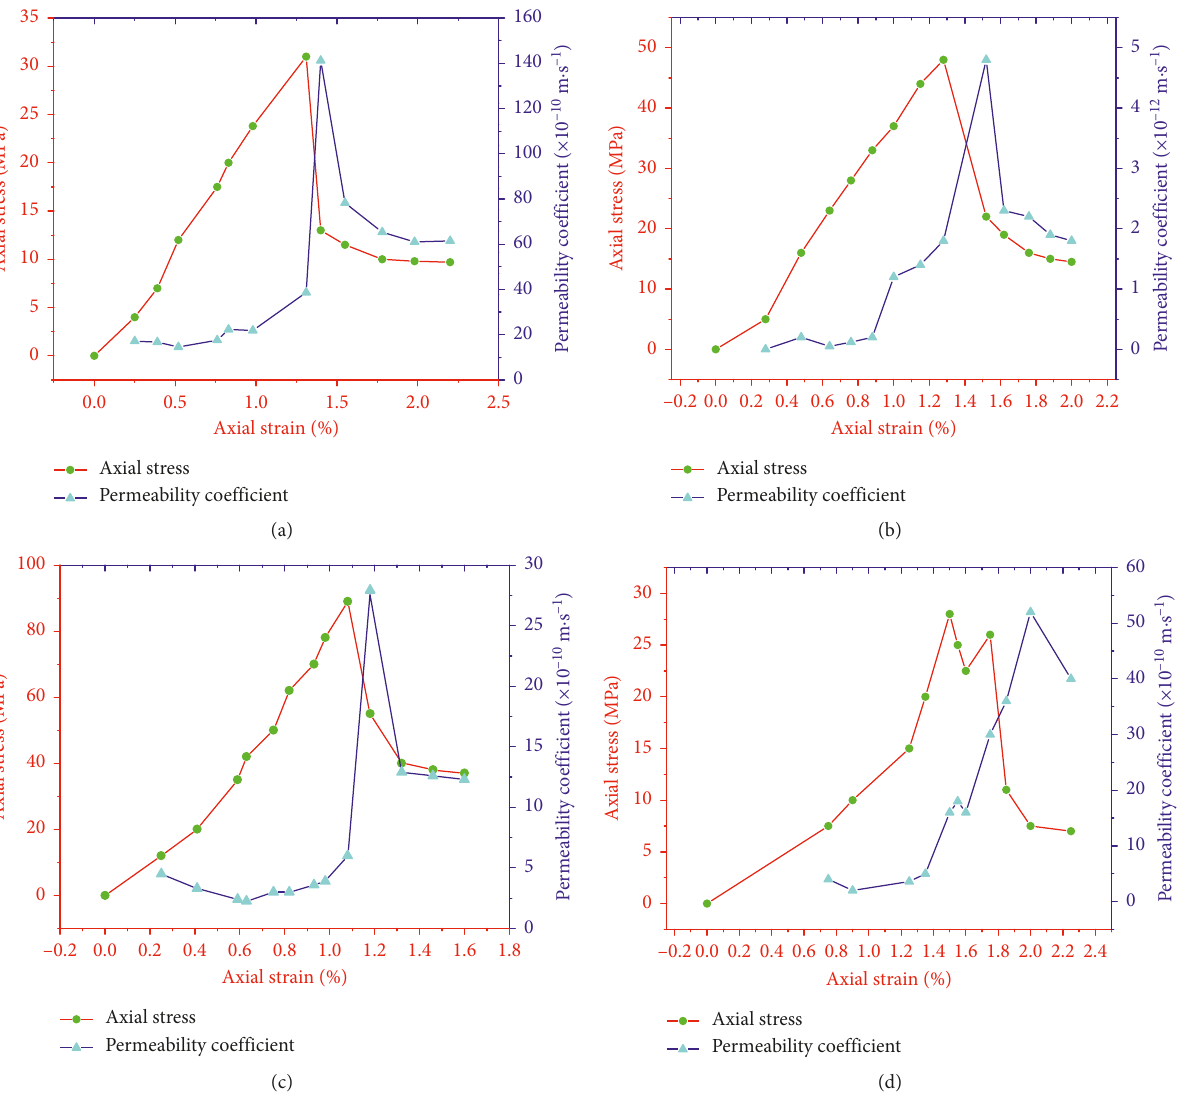
Figure 7: Stress-varying permeability coefficient ( K ) variation curves for rocks of different lithological properties. (a) Coal. (b) Mudstone. (c) Sandstone. (d) Sandy